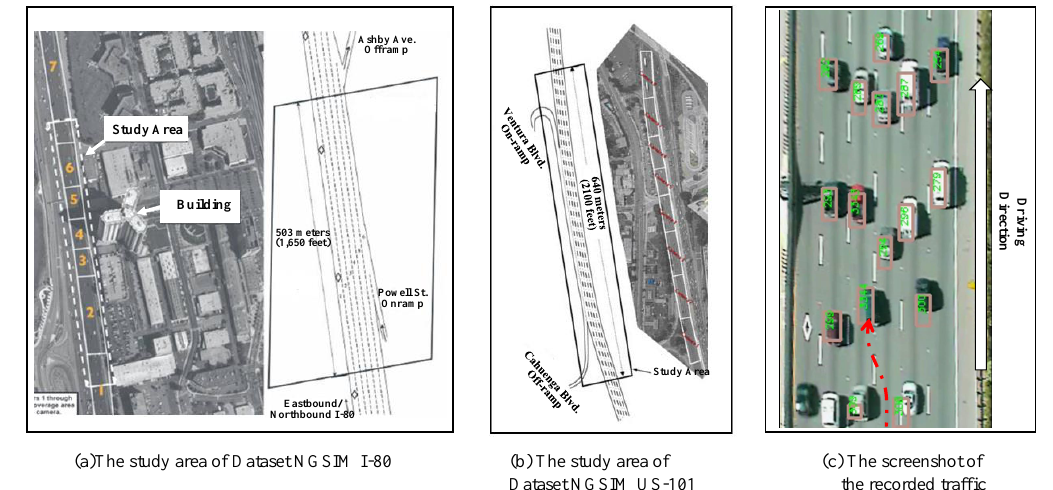
Figure 5. Overview of traffic environments on two datasets